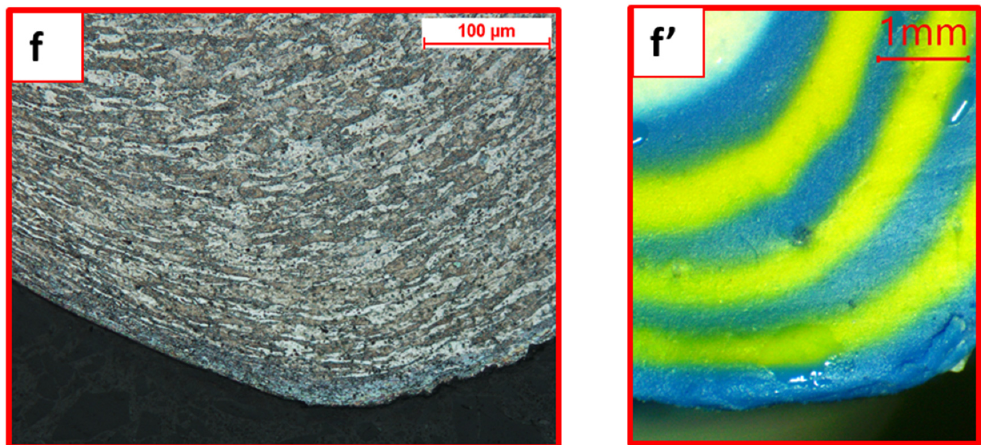
Figure 14. Cross sections of steel and model plasticine clinched joints: ( a , a’ ) base material, ( b , b’ ) pre- necking region, ( c , c’ ) necked region, ( d , d’ ) stretched corner, ( e , e’ ) base plate and ( f , f’ ) groove.